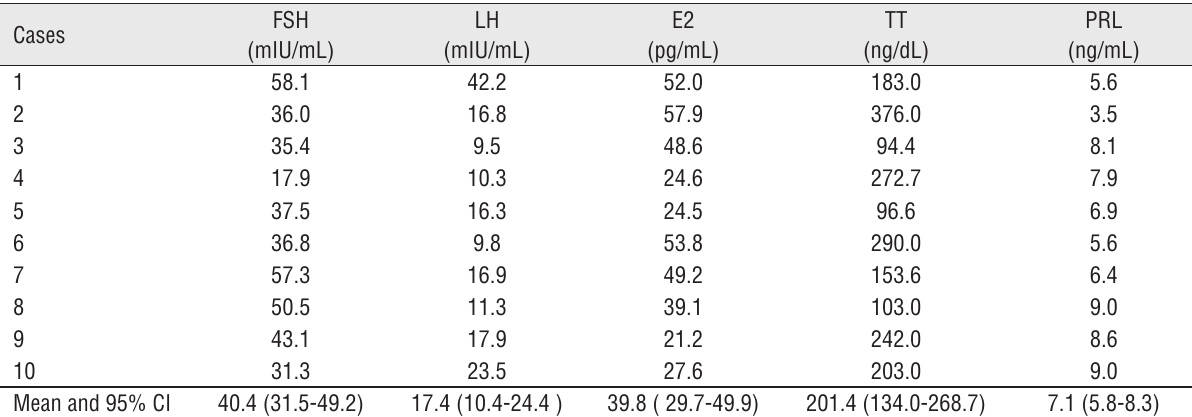
Table 2 - hormonal status of the